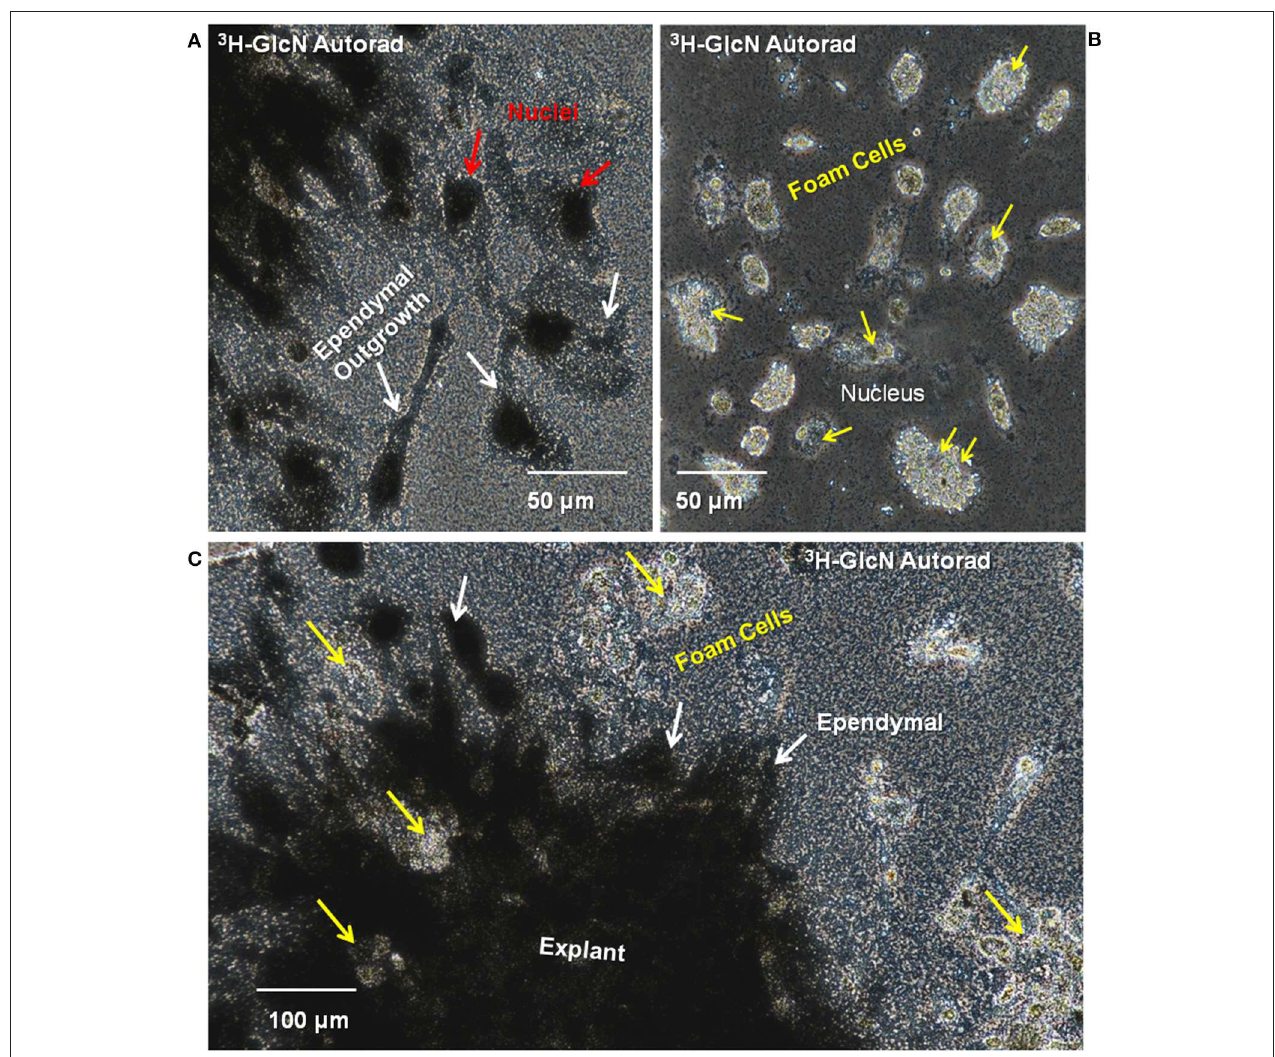
FIGURE 12 | Ependymal cells in cord explant cultures synthesize ECM components. Synthesis of glycosaminoglycan and proteoglycan was investigated by incubating explants with 3 H-glucosamine and performing culture dish autoradiography. (A) Silver grains were detected in the ependymal cell nuclei (red arrows) and cytoplasm (yellow arrows). (B) No silver grains were deposited on or around the foamy macrophages. Yellow arrows indicate foamy macrophage nuclei. (C) Lesion site explants is heavily labeled with silver grains. Patches of unlabeled foamy macrophages are found within the explants (yellow arrows) and beyond the ependymal cells (white arrows). 3H, tritiated; GlcN, glucosamine; Autorad, autoradiography. Magnification bars are shown in the lower portion of the